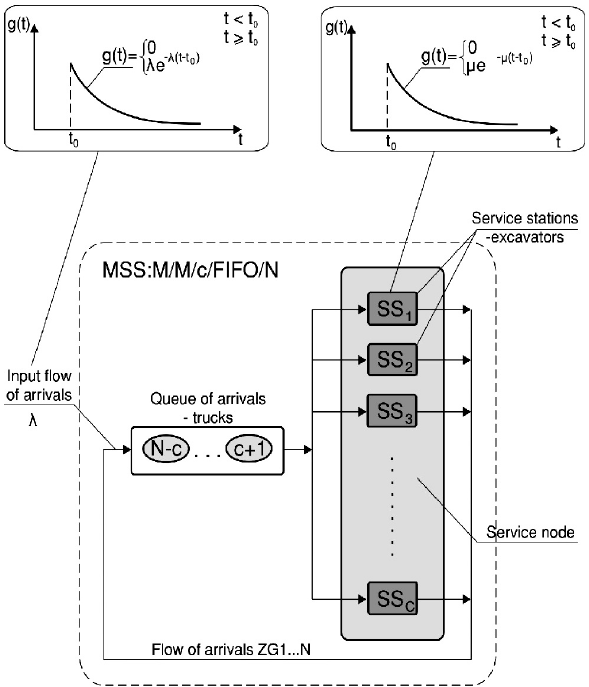
Fig 2 . Diagram of mass service system considered